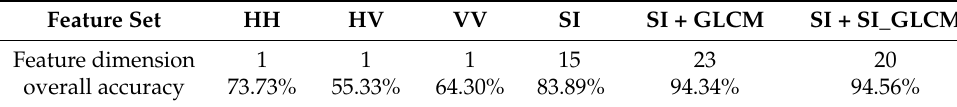
Table 5. Accuracy results of feature classification in Shijiu